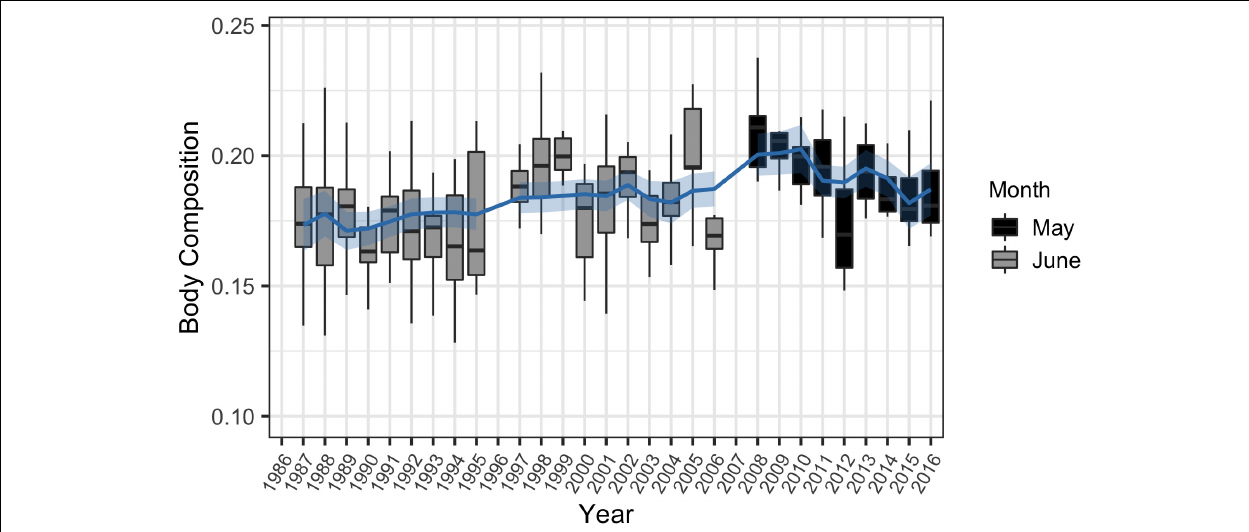
FIGURE 7 | Fitted generalized additive model with 95% confidence interval for long term trends in body composition for male and female common bottlenose dolphins ( Tursiops truncatus ) of all ages in Sarasota Bay between 1986 and 2016 ( n = 480). Analyses were restricted to May and June to reduce effects of seasonal sampling